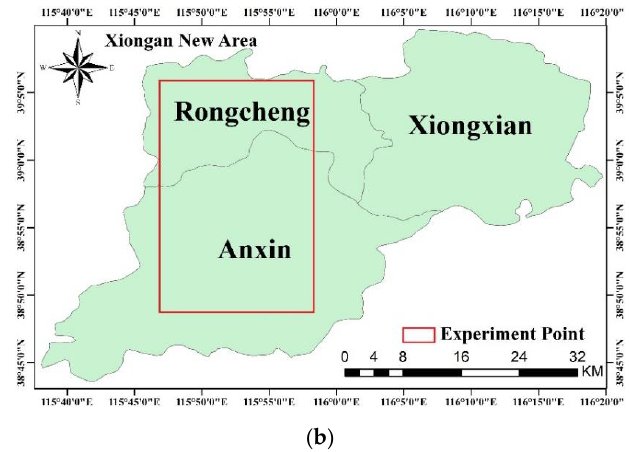
Figure 2. Study areas at ( a ) Qiqihaer City and ( b ) the Xiong’an New Area.